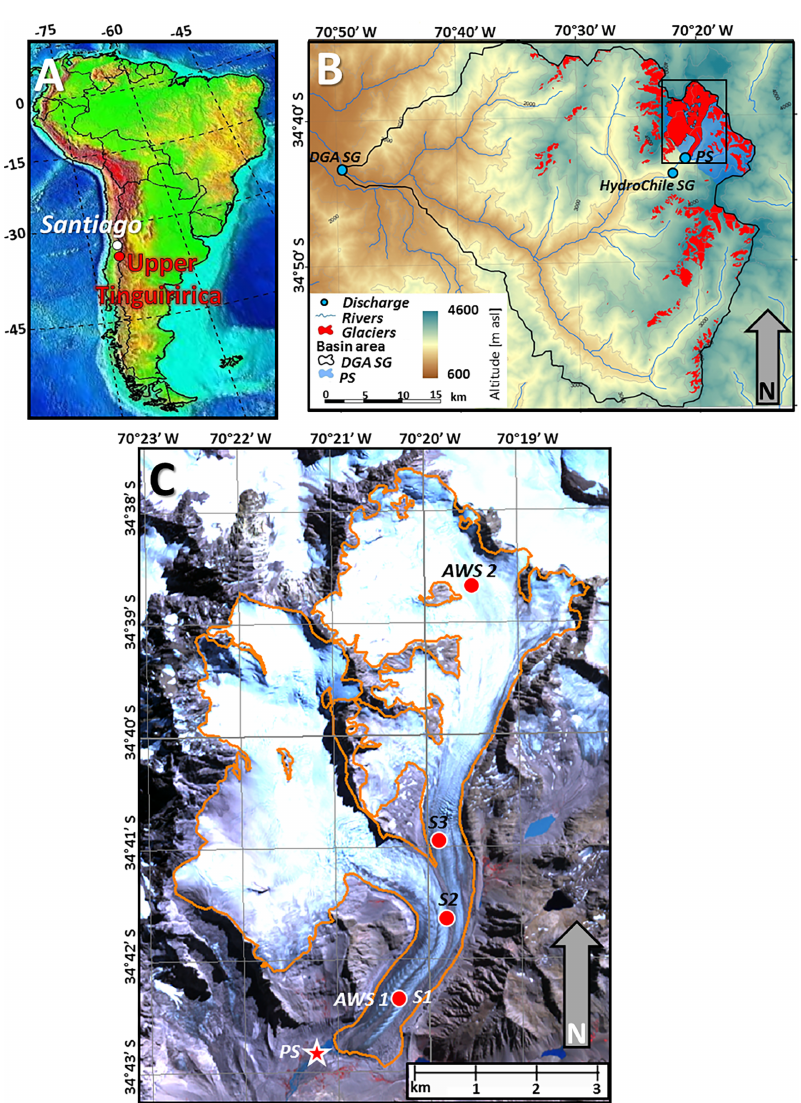
Figure 1. Location of Universidad Glacier in central Chile. Panel (a) shows the regional location, (b) shows the upper Tinguiririca Basin and (c) shows Universidad Glacier (orange outline), automatic weather stations (AWS) and ablation stakes (S) installed. PS indicates the location of the pressure sensor; SG indicates the locations of the DGA and HydroChile stream gauge. The background is an ASTER image from 27 March 2010, UTM